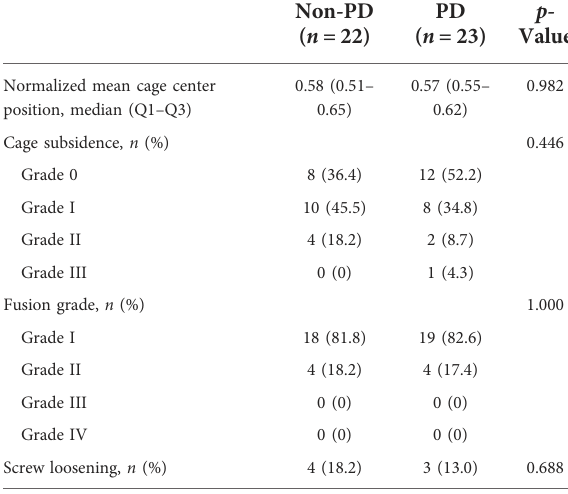
TABLE 4 Cage position and cage-related parameters.